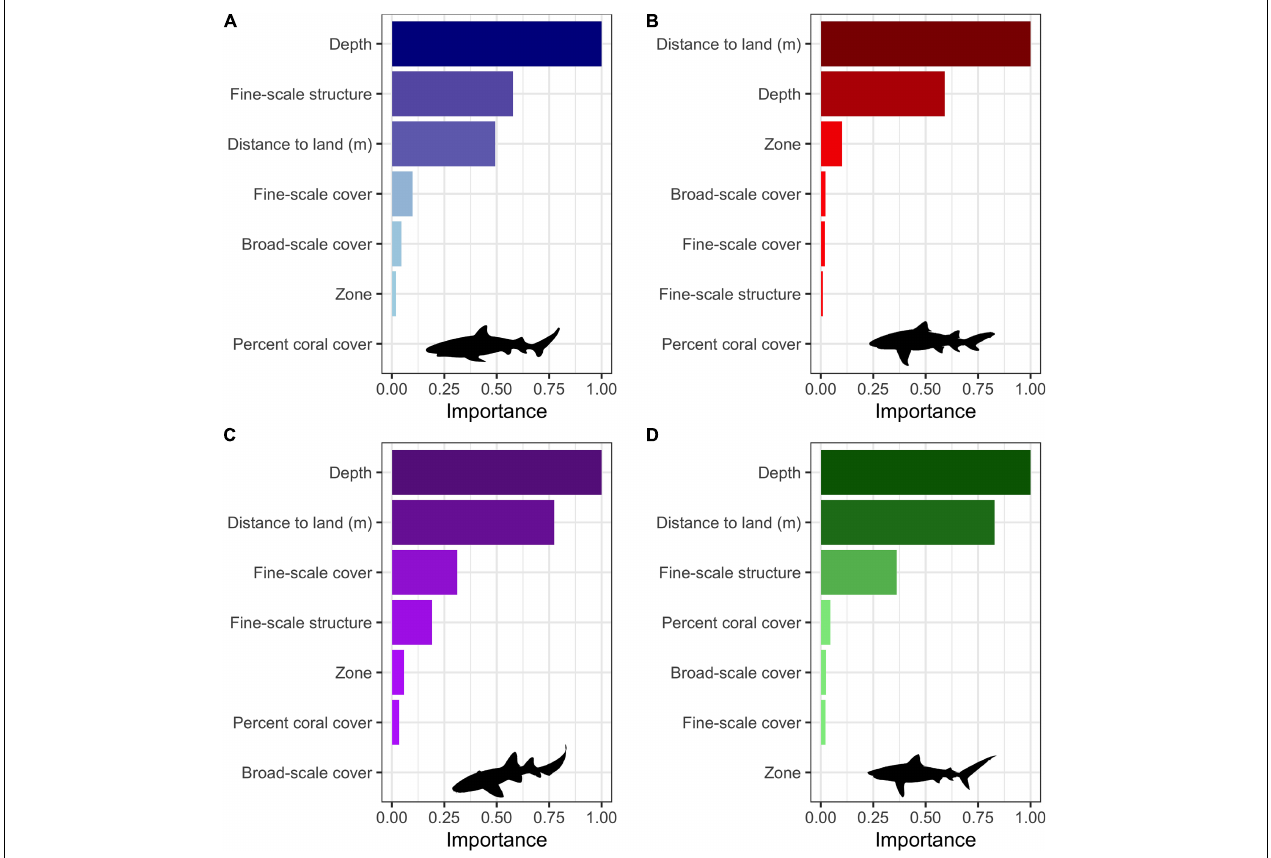
FIGURE 2 | Feature importance, indicating how important each predictor variable is within each shark random forest model for (A) Caribbean reef sharks, (B) lemon sharks, (C) nurse sharks, and (D) tiger sharks. Higher values and darker colors indicate greater relative importance. Values were calculated using the mean decrease in accuracy method and, subsequently, all importance values were normalized from 0 to 1 for comparison across